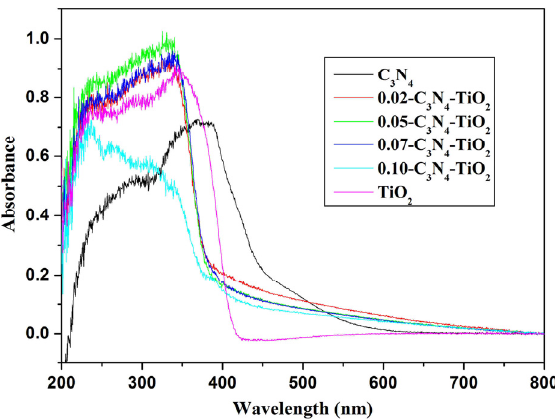
Figure 3. UV ‐ Vis absorption spectra of g ‐ C 3 N 4 ‐ TiO 2 . Figure 3. UV-Vis absorption spectra of g-C 3 N 4 -TiO 2 .